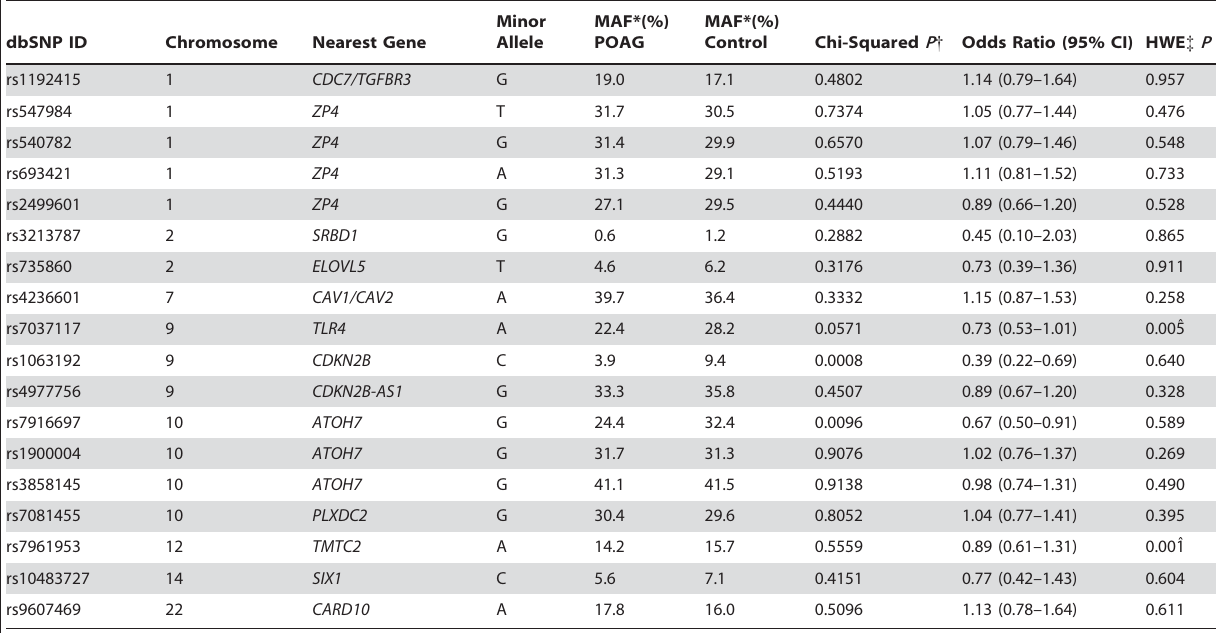
Table 3. Allelic tests of SNPs.